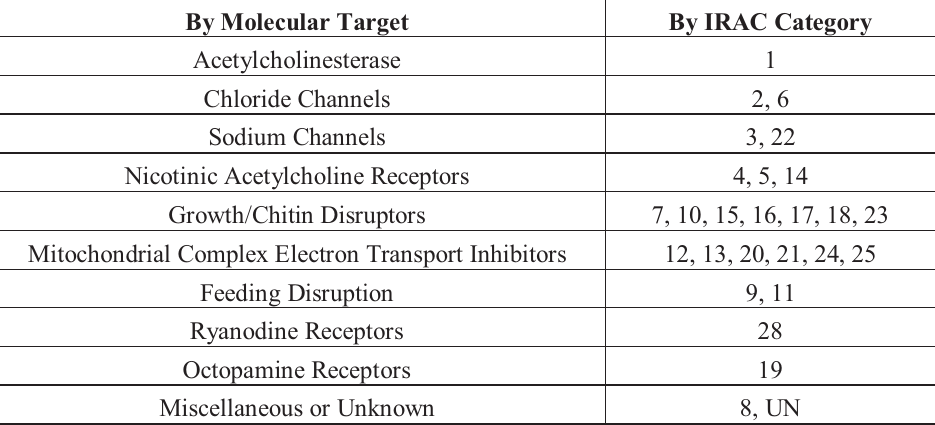
Table 2. Classification of insecticides based on molecular